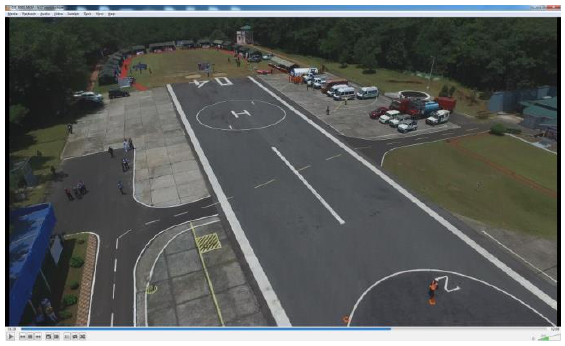
Figure 4: Image captured during disaster drill using UAV